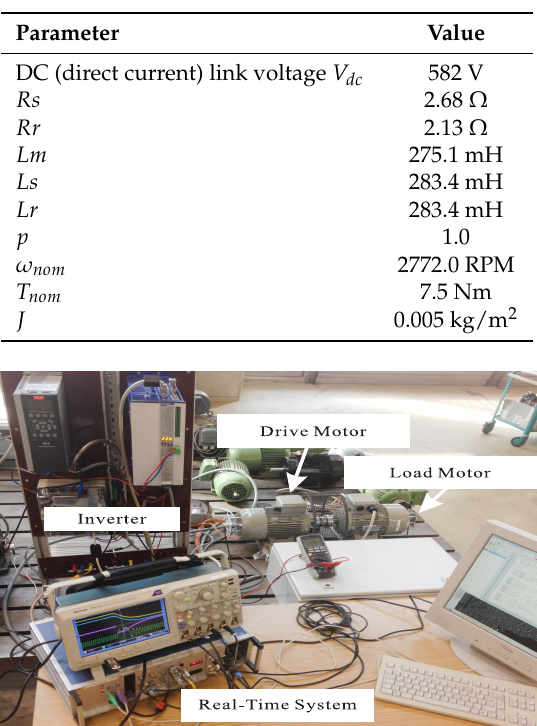
Table 2. Parameters of the induction machine.